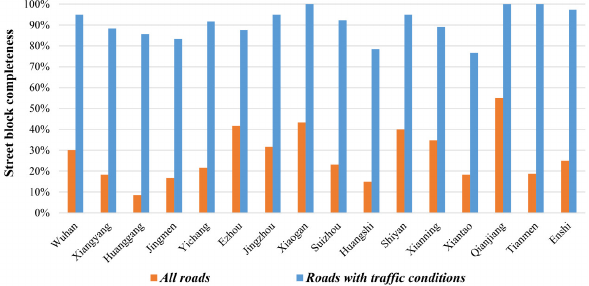
Figure 5. Street block completeness values for the urban